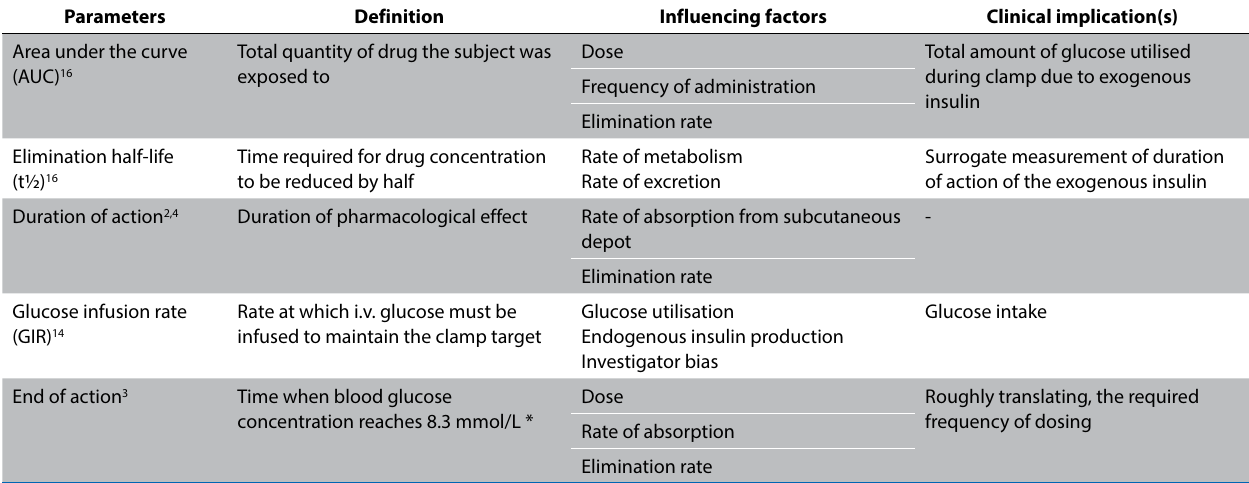
Table 1: General outcome measures of the euglycemic glucose clamp study Parameters